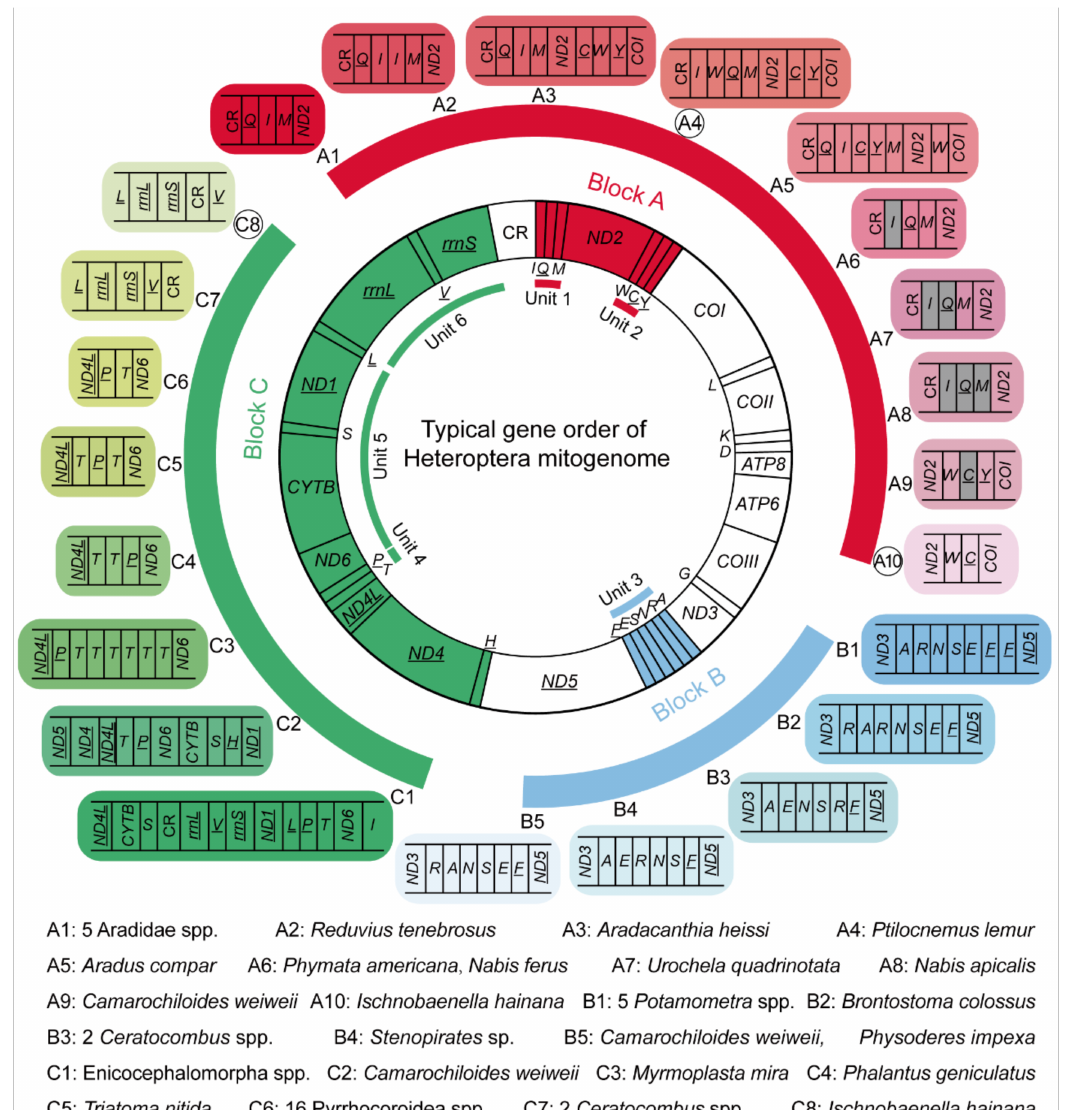
Figure 5. Typical gene order of heteropteran mitogenome and rearranged gene orders observed in true bugs. Blocks A–C denote mitochondrial genes involved in gene rearrangements. A1–A10, B1–B5, and C1–C8 indicate different gene orders for each block, of which A4, A10, and C8 with black circle are new gene rearrangements reported in this study. Units 1–6 indicate six divided rearrangement unit. Genes in gray are missing in corresponding mitogenomes. Genes marked with underline are located on the minority